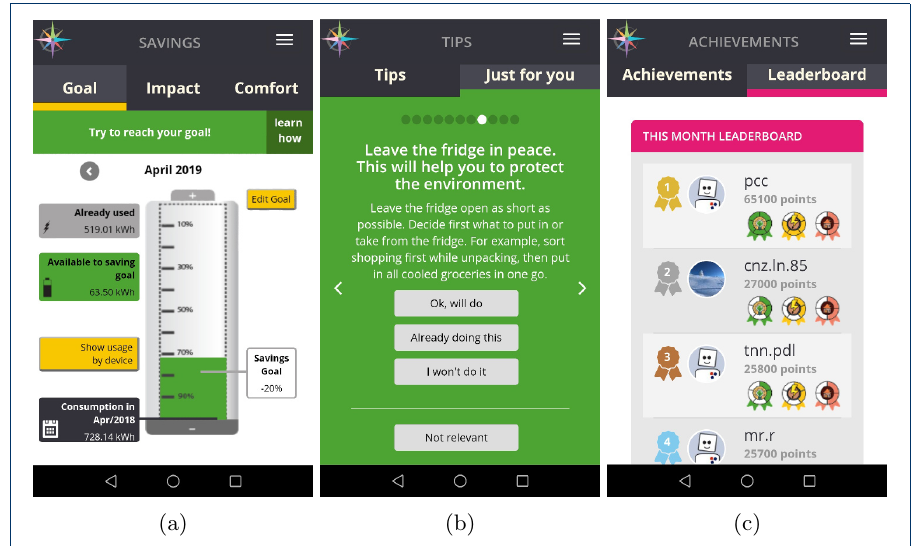
Figure 1: enCOMPASS Goal, Personal Recomendations and Leaderboard